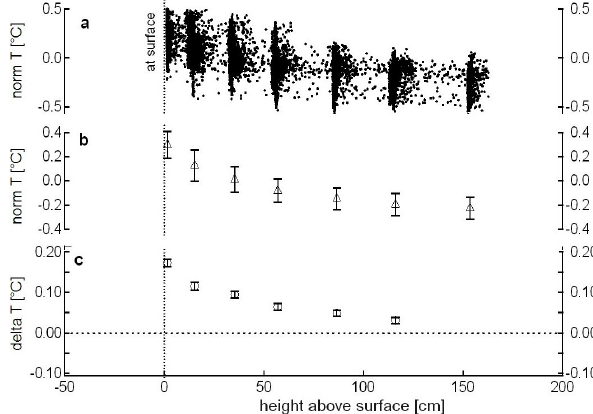
Fig. 3. Significance of temperature gradient in profile data: (a) indi- vidual data points of normalized temperature, (b) normalized tem- perature averaged at each height with the standard deviations as the error bars, and (c) the difference between adjacent means from left to right with ± twice the standard errors as the error